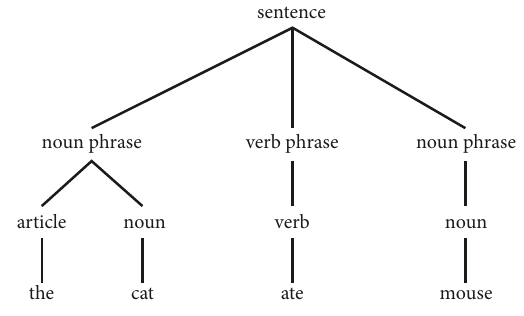
Figure 1: An example of a parsing tree.